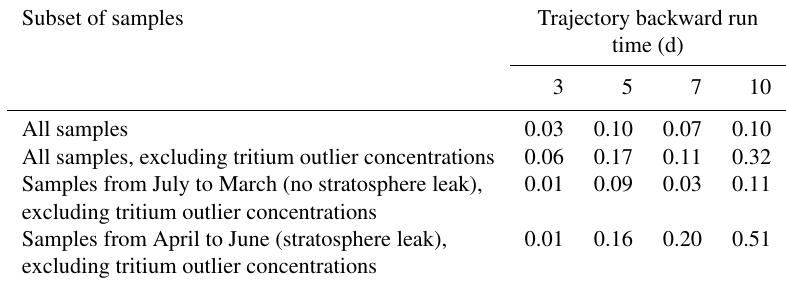
Table 3. Coefficients of determination for the correlation of the measured tritium concentration against the moisture-source-weighted median altitude (Fig. 6) for different trajectory